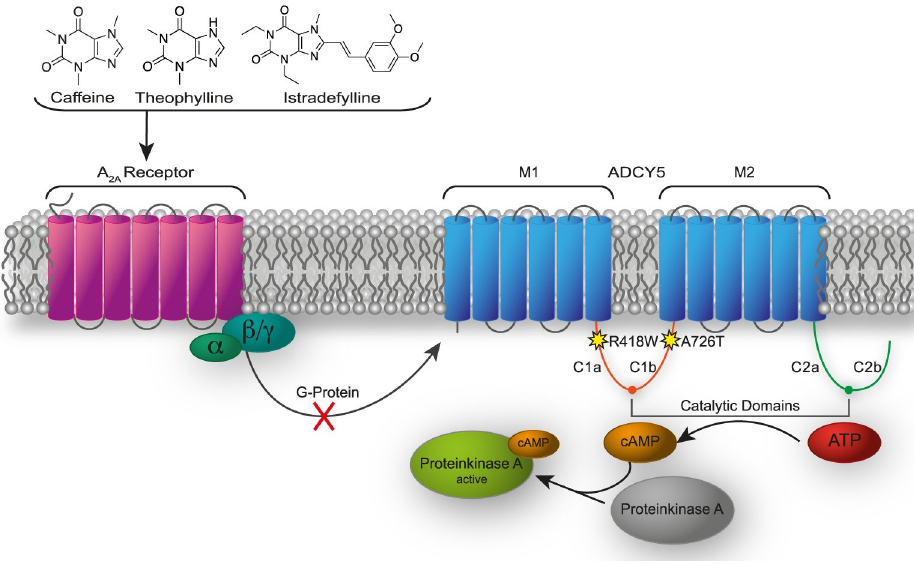
Fig 1. Mode of action for caffeine, theophylline, and istradefylline on the reduction of cAMP production by ADCY5 via inhibiting the A 2A